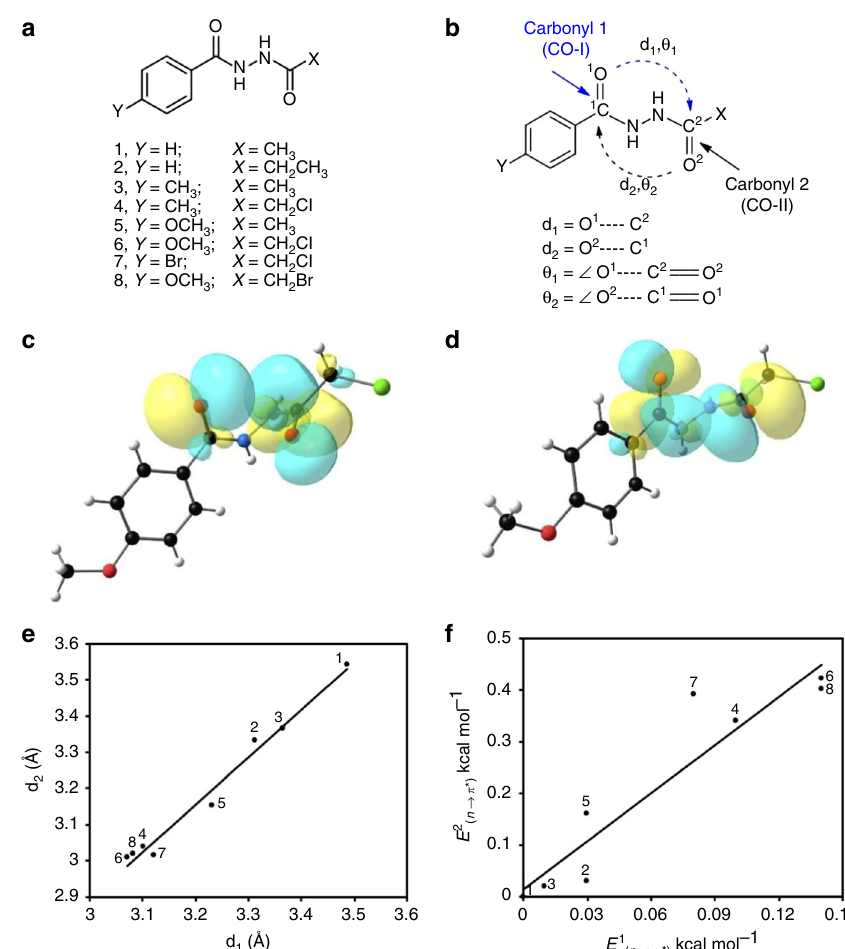
Fig. 2 Model compounds synthesized to study reciprocal n → π * interactions. a Chemical structures of N , N ʹ -diacylhydrazines ( 1 – 8 ). b De fi nition of different structural parameters in N , N ʹ -diacylhydrazines 1 – 8 ; d 1 = O 1 ··· C 2 ; d 2 = O 2 ··· C 1 ; θ 1 = ∠ O 1 ··· C 2 = O 2 ; θ 2 = ∠ O 2 ··· C 1 = O 1 . c NBO orbital overlap between oxygen lone pair ( n O ) of CO-I and π * C = O orbital of CO-II of compound 6 . d NBO orbital overlap between oxygen lone pair ( n O ) of CO-II and π * C = O orbital of CO-I of compound 6 . e Plot showing correlation between O ··· C distances (d 1 and d 2 ) in compounds 1 – 8 [Linear fi tting; Pearson correlation coef fi cient = 0.9906]. f Plot showing correlation between reciprocal n → π * interaction energies [ E 1 ( n → π *) and E 2 ( n → π *) ] in compounds 1 – 8 [Linear fi tting; Pearson correlation coef fi cient = 0.938]. Curved dotted arrows indicate n → π *